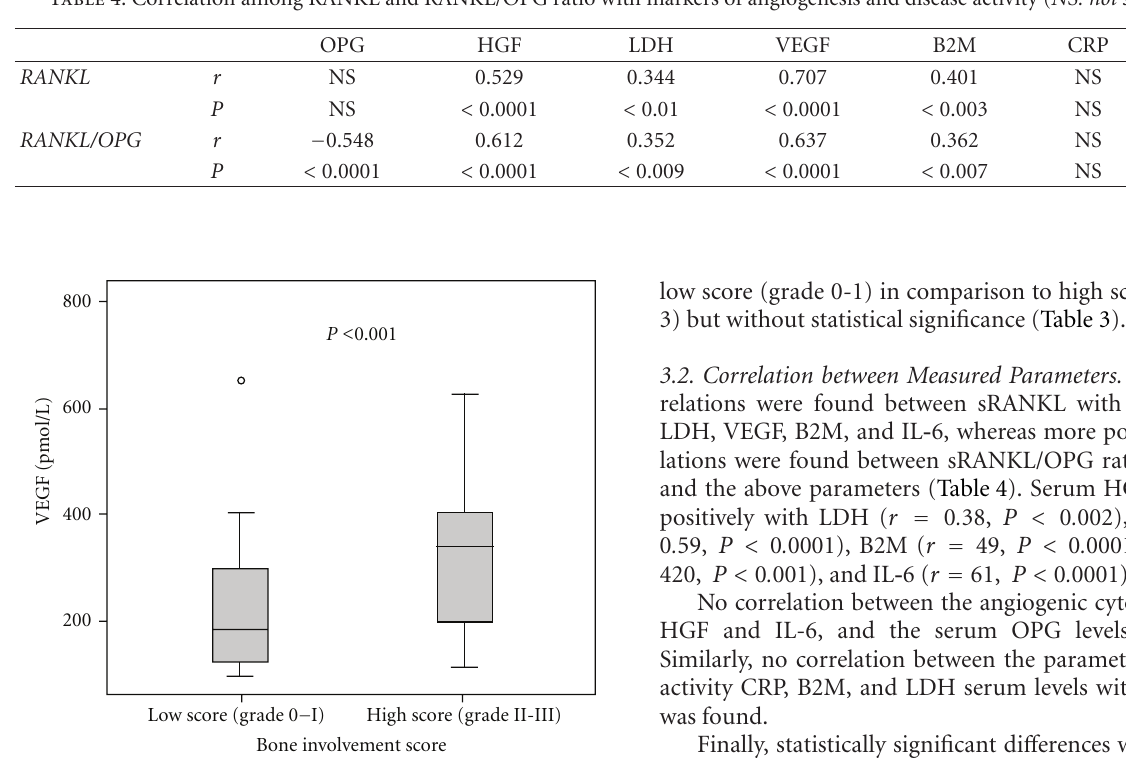
Table 4: Correlation among RANKL and RANKL/OPG ratio with markers of angiogenesis and disease activity ( NS: not significant ).